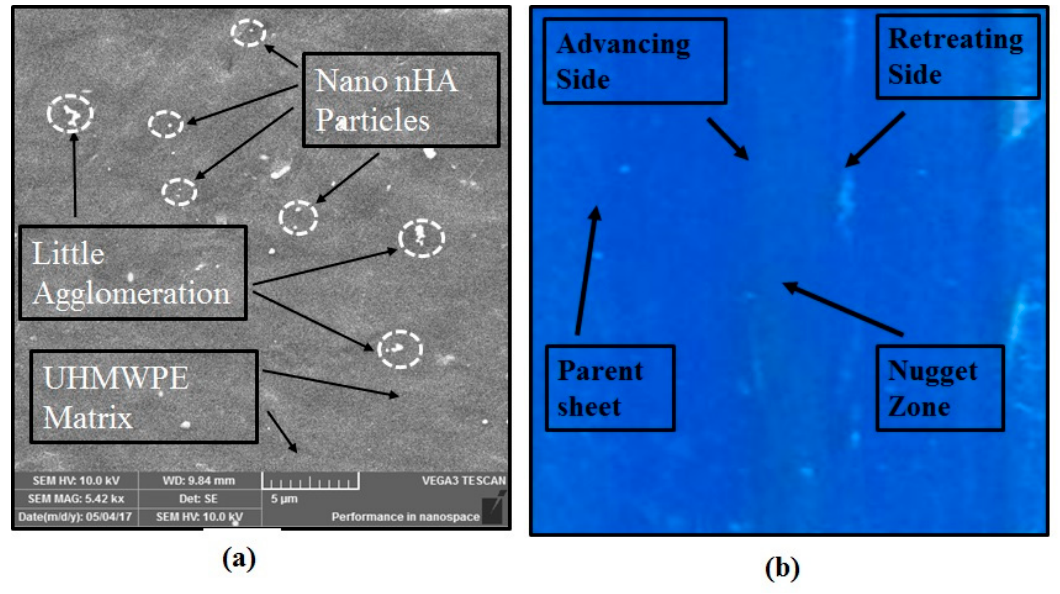
Figure 7. Experiments with better results: ( a ) Relatively better nano hydroxyapatite (nHA) particle distribution in experiment 11, and ( b ) Better surface finish in experiment 23.